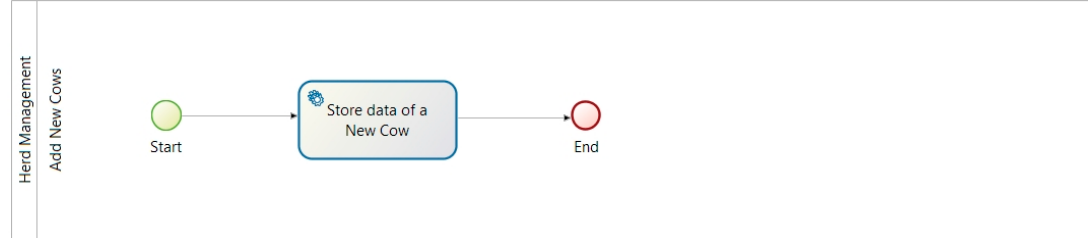
Figure 10. Example of a business process used to store a set of inputs in the software application database. In the diagram, using the business process management notation (BPMN), the business process “Add new cow” is reported.